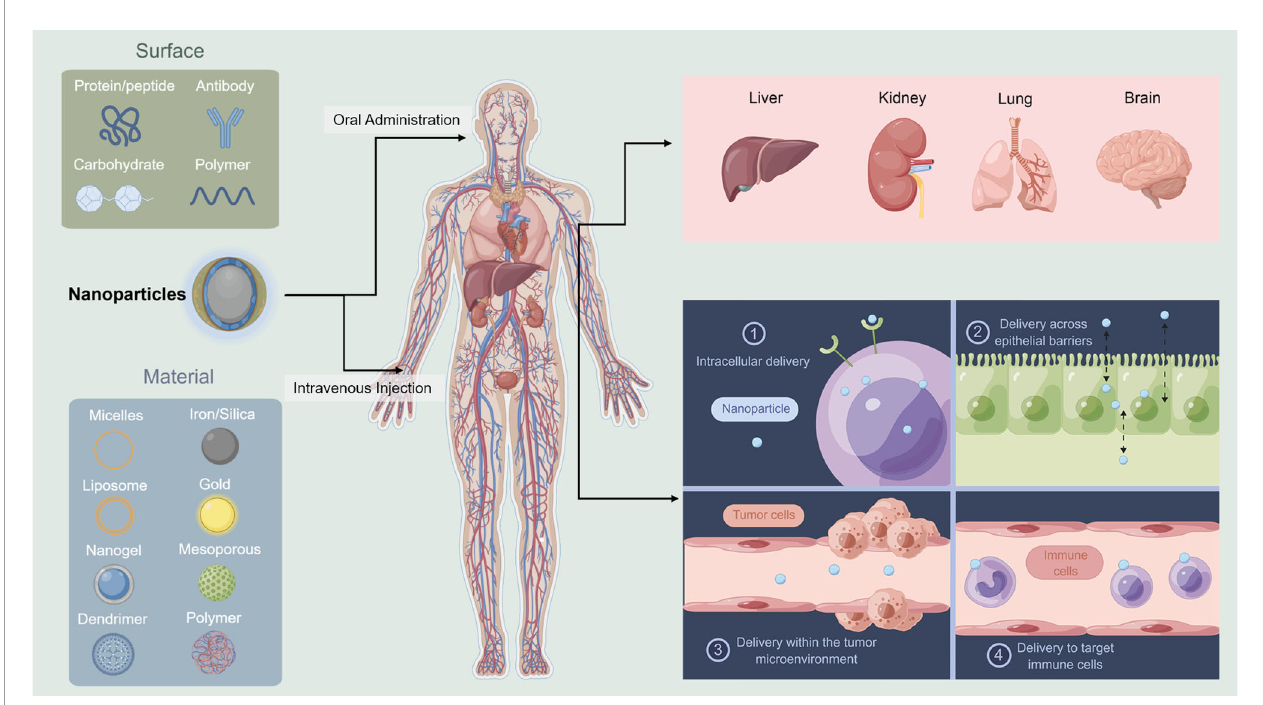
FIGURE 1 | Schematic illustration of nanoparticles delivery system. Liver and kidney can fi lter most of the NPs. Different NPs are used in different administration ways (This fi gure was drawn by